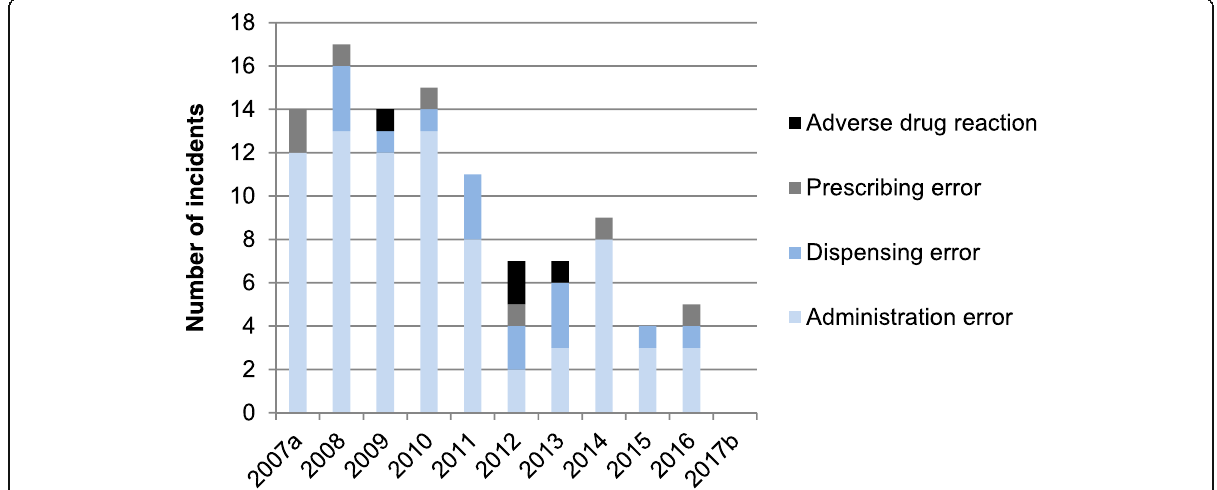
Fig. 5 Annual numbers of Kampo medicine-related incidents. a: Data for 8 months, from May to December 2007. b: Data for 4 months, from January to April